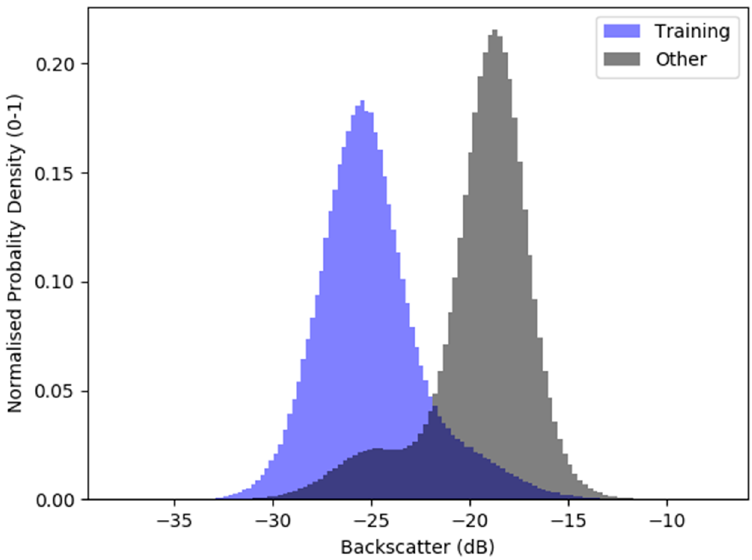
Figure 5. Example histogram for a relatively dry period showing the difference between open water pixels (‘training’) and lumped open water and low-backscatter areas